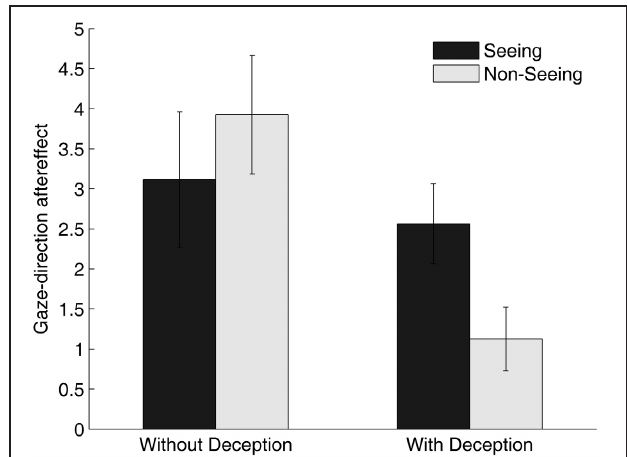
FIGURE 2 | Gaze-direction aftereffects in the Seeing and Non-Seeing condition. The left panel shows the results of the current study (without deception); in the panel on the right, results from the second experiment of our previous study (with deception; Teufel et al., 2009) are re-plotted for comparison purposes. Aftereffects were calculated by subtracting the judgment scores for the rightward adaptation from the leftward adaptation conditions. Larger gaze-direction aftereffects indicate a larger difference in the influence of adaptation on subsequent gaze-direction perception between the rightward vs. the leftward adaptation